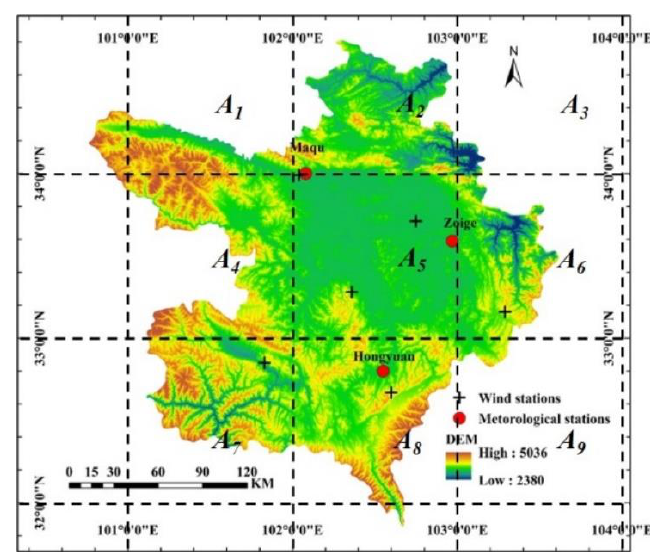
Figure 1. Digital elevation model (DEM) of the Zoige wetland, China. Three meteorological stations (red dots) and six wind measurement sites (black crosses) are identified.